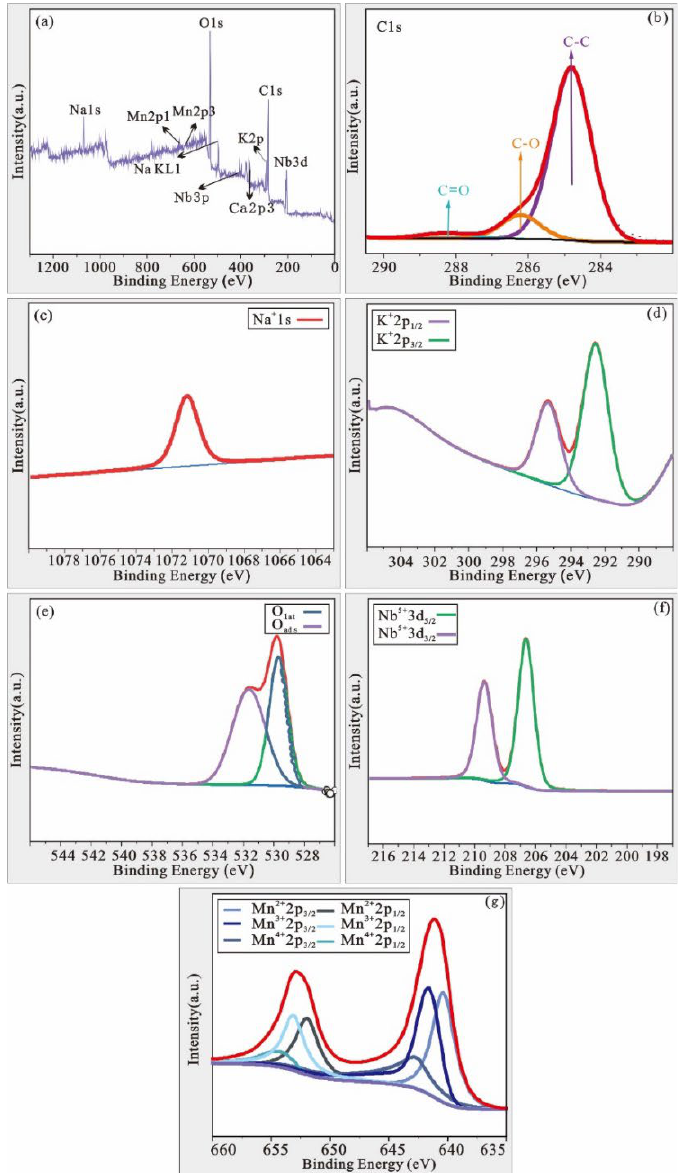
Figure 13. XPS pattern analysis of KNMN coating: ( a ) XPS full spectrum; ( b ) C1spectrum; ( c – g ) K, Na, Nb, O, and Mn XPS mapping.